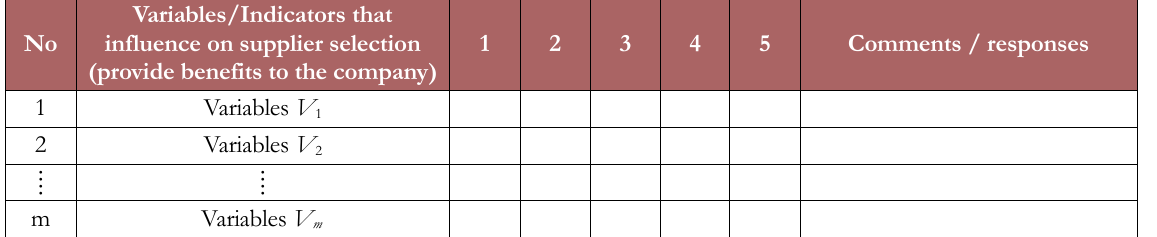
Table 1. Example of Questioner I